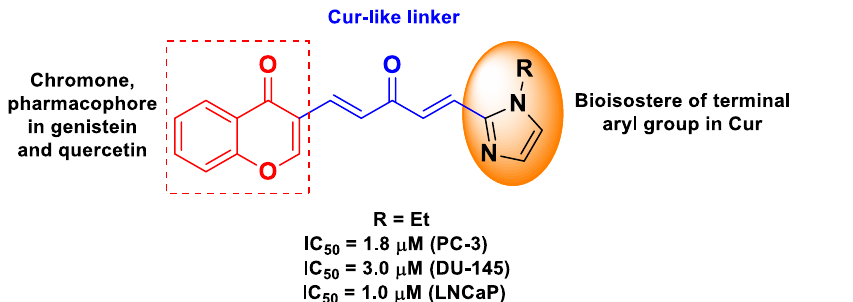
Figure 14. Structure and activity of the most potent hybrid compound developed by Chen et al. [62]. Botta et al. synthesized a library of monomeric and dimeric fused hybrids by cou- pling the semisynthetic derivatives of artemisinin, i.e., artesunate and dihydroartemisinin, with various phytochemicals, i.e., Cur, eugenol, perillyl alcohol, tyrosol, and α - and δ -tocopherol [64]. Artemisinin, as well as its semisynthetic derivatives with improved pharmacological and pharmacokinetic profiles compared with the parent compound, is a sesquiterpene lactone from Artemisia annua endowed with remarkable activity against different cancer cell lines exerted by means of the iron-mediated cleavage of its reactive 1,2,4-trioxane ring [78]. Among the hybrids of this series, the dimer artesunate-Cur-artesunate obtained by simple ester linkage between the -OH phenol group of Cur and the -COOH group of artesunate emerged as the most interesting derivative in terms of biological outcomes (Figure 15). Indeed, it exhibited notable antiproliferative (low-micromolar range) activity against HeLa cells and three complementary metastatic melanoma cancer cell lines (SK-MEL3, SK-MEL24, and RPMI-7951) without toxicity against normal cells (human primary fibroblast cell line C3PV). Moreover, assays with the iron-chelating agent deferoxamine surprisingly indicated that this dimeric hybrid does not exert anticancer activity by means of the free radical formation variance exhibited by the other hybrids of this series of derivatives [64].